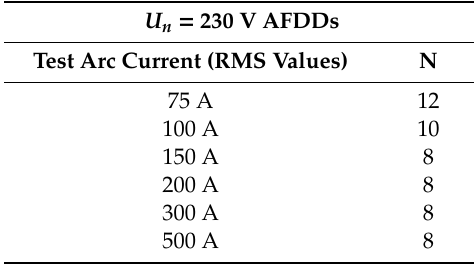
Table 3. Maximum allowed number of arcing half-cycles within 0.5 s for U r = 230 V AFDDs and U r = 120 V AFDDs in the parallel arc